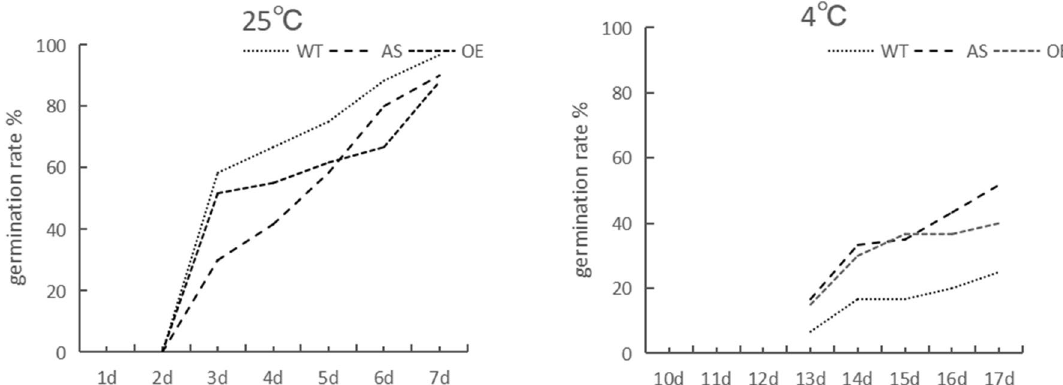
Figure 1. The trend of germination rate with germinating days.